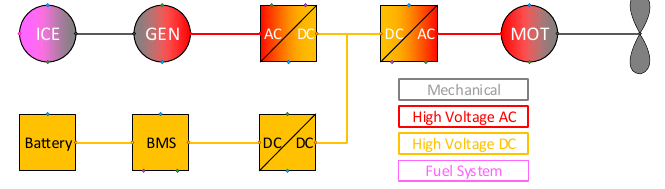
Figure 9. Serial hybrid propulsion system.